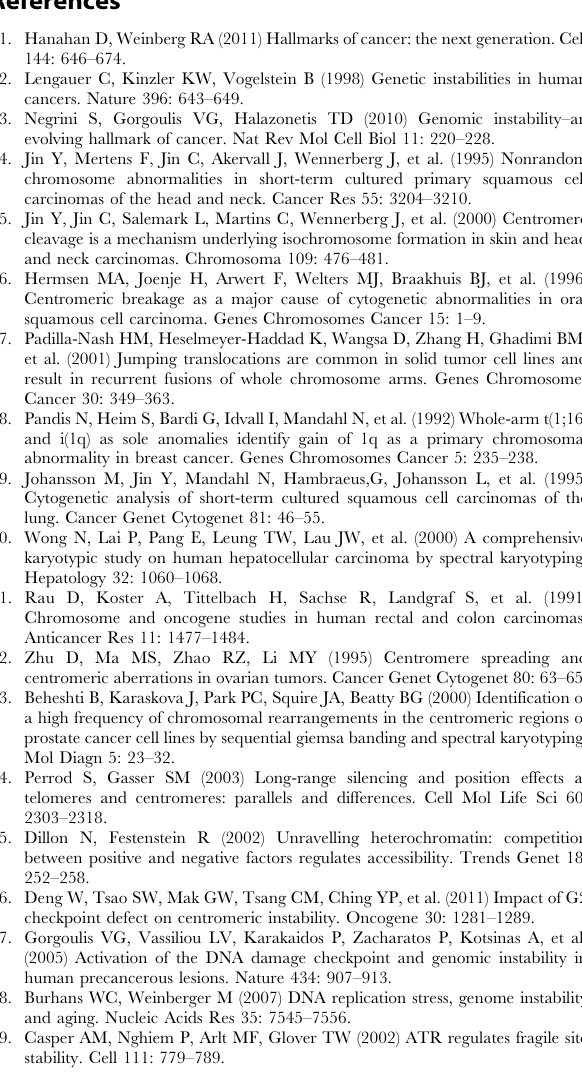
Table S1 Structural chromosome aberrations in esoph- ageal and cervical epithelial cells expressing HPV16 E6E7 and hTERT a . Table S2 Karyotype at population doubling 80 of cell lines immortalized by HPV16 E6E7 and hTERT a